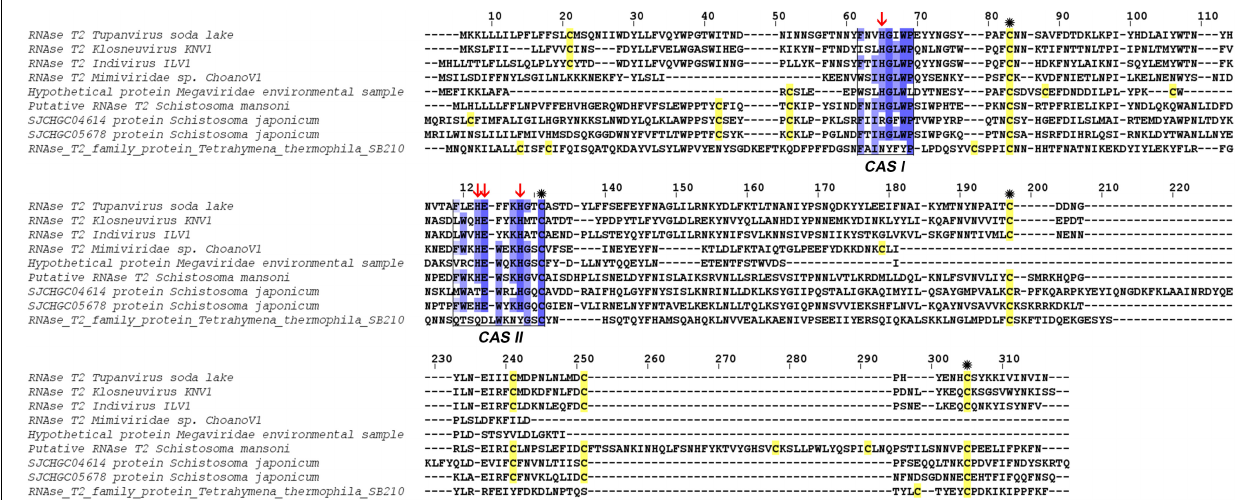
FIGURE 6 | Alignment of RNase T2 sequences from phylogeny. The alignment shows TPV-SLRNase T2 sequence compared with sequences of all other giant viruses and closest eukaryotes in phylogeny. CAS I and CAS II regions, characteristic of RNase T2 enzyme, are marked and conserved amino acids enlighten in blue (the intensity of color increase with the degree of conservation). Catalytic histidines are pointed with red arrows and cysteines stained in yellow with those important for the active site marked with an asterisk.